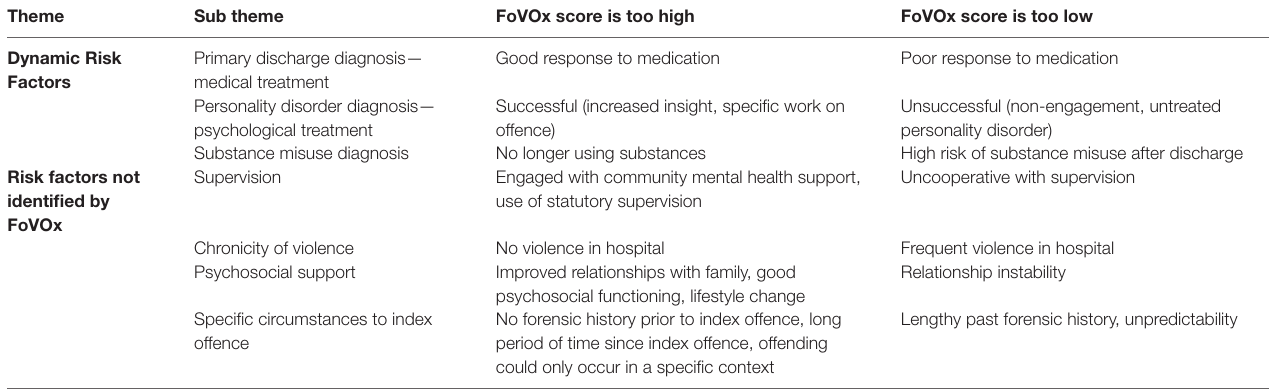
TABle 2 | Qualitative feedback on challenges with FoVOx scoring.